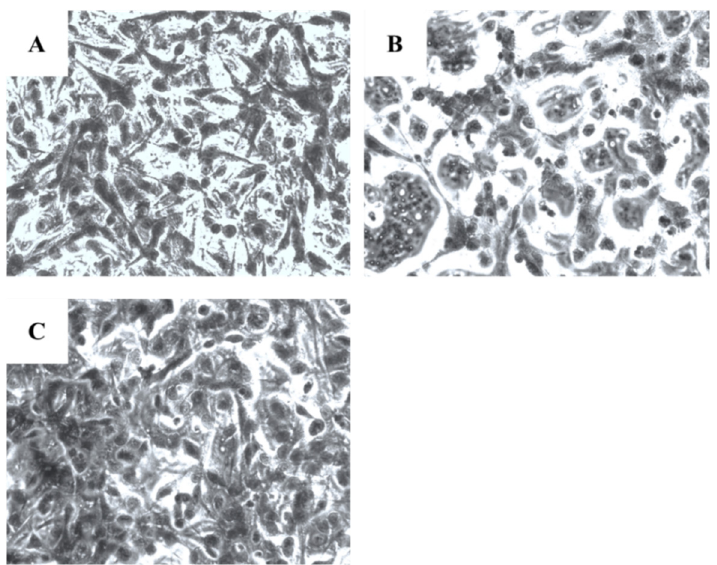
mg/mL of the extract ( C ). Images were captured at ×200 magnification.